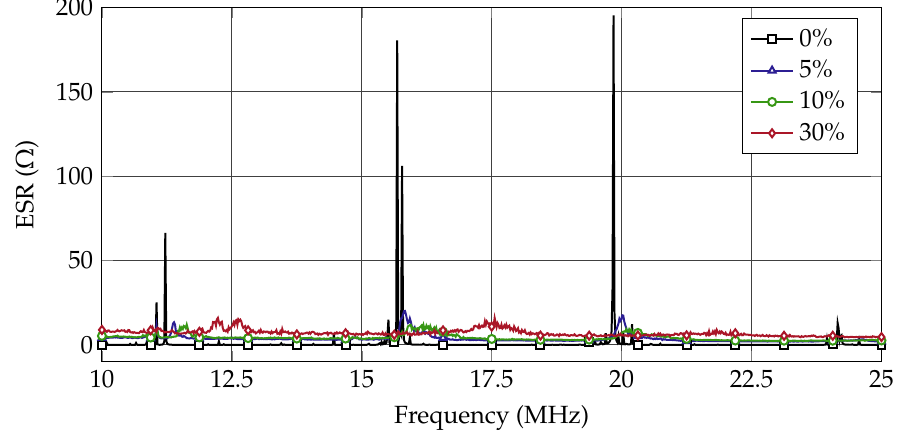
Figure 3. Comparison of mean µ ESR extracted from 2D simulation model with increasing com- position percentages of inclusions. Considerable suppression of acoustics is observed here, with a tolerable increase in ESR at non-acoustic